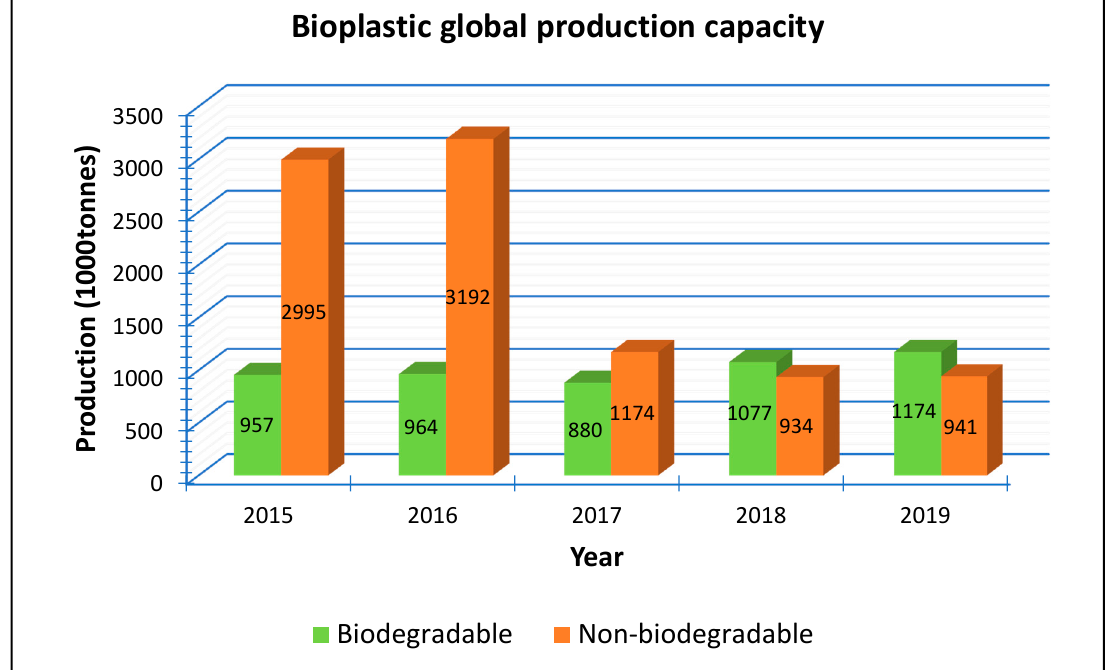
Figure 3. Share of biodegradable and non-biodegradable bioplastics production capacities (2015 to 2019). Data from [64].